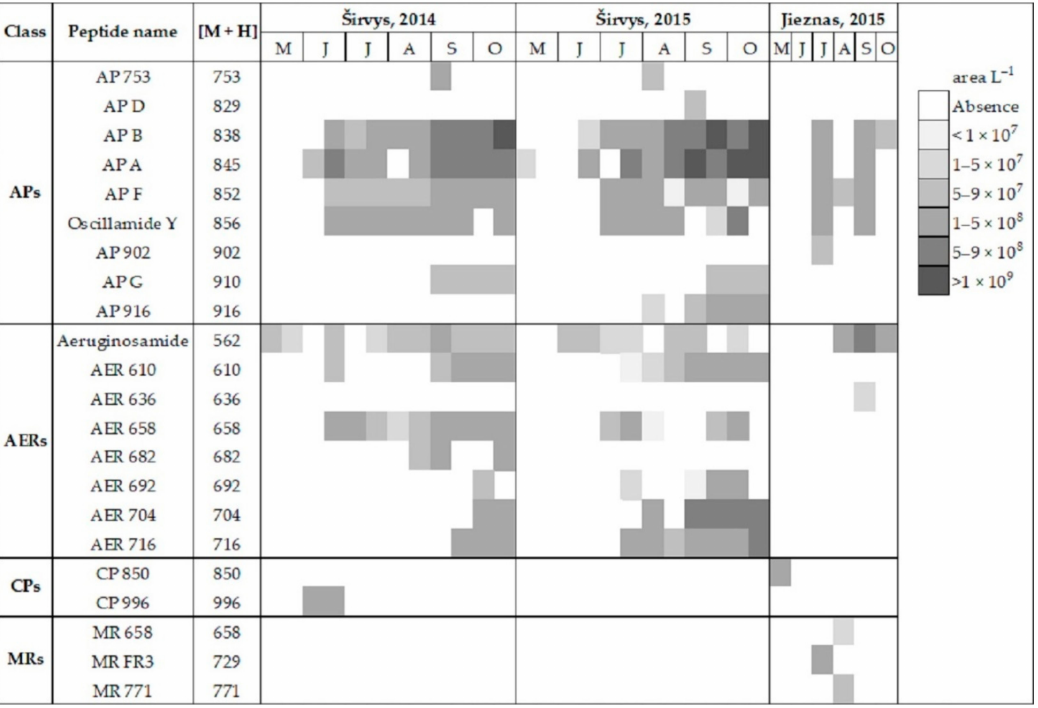
Figure 3. Profile of non-ribosomal peptides (NRPs) in the water samples of Širvys (monodominant) and Jieznas (polidominant)